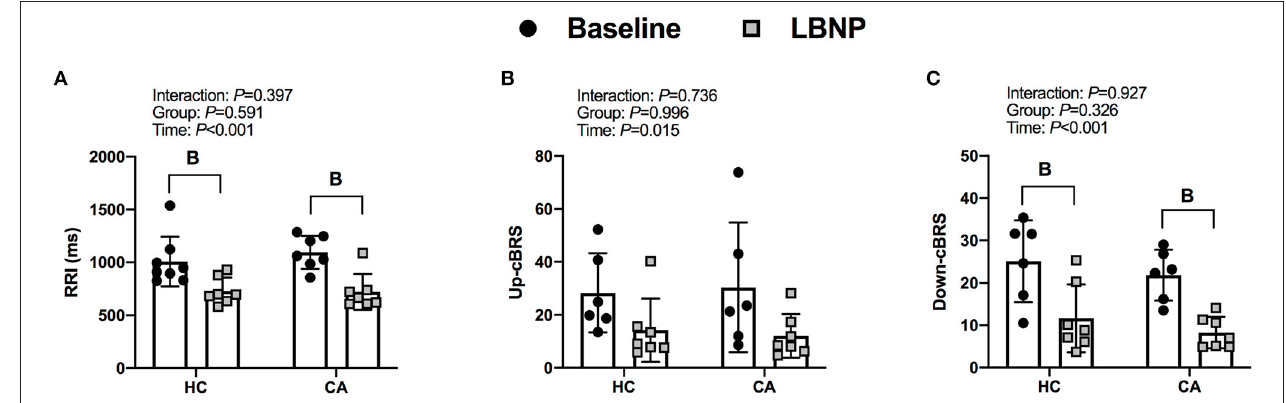
FIGURE 2 | R-R interval (A) , Up cardiac- baroreflex senstivity (B) , and Down cardiac-baroreflex sensitivity (C) for Healthy Controls and Concussed Athletes at baseline and LBNP. B, different from Baseline, ( P ≤